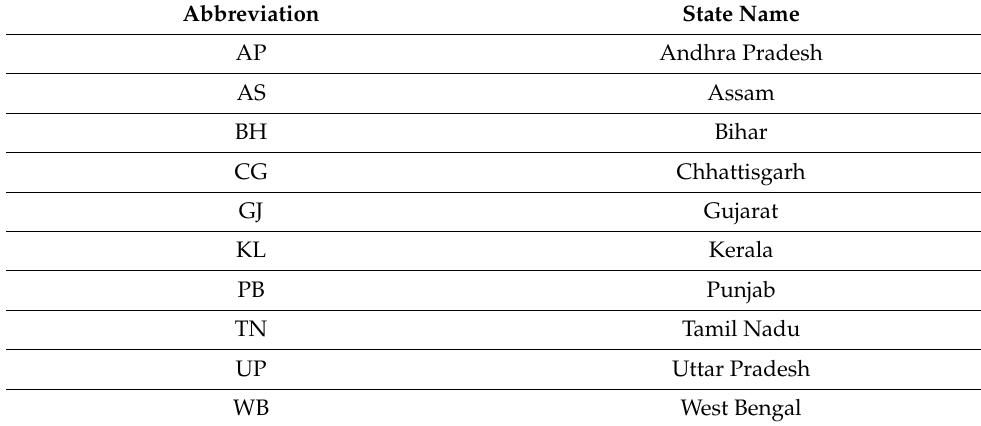
Table A2. Abbreviations for states.